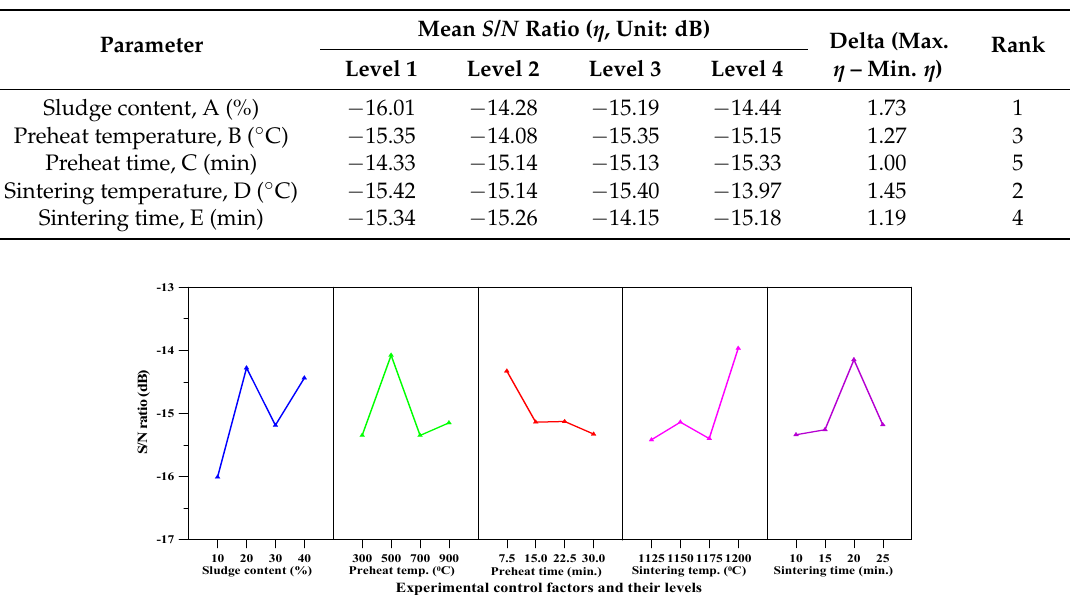
Figure 6. S / N response graph for loss on ignition.